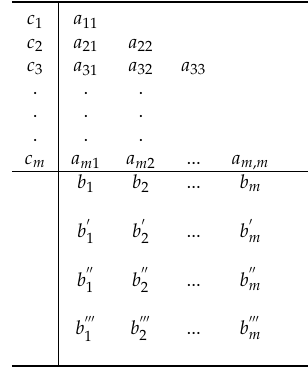
Table 1. The Butcher tableau DIRKT